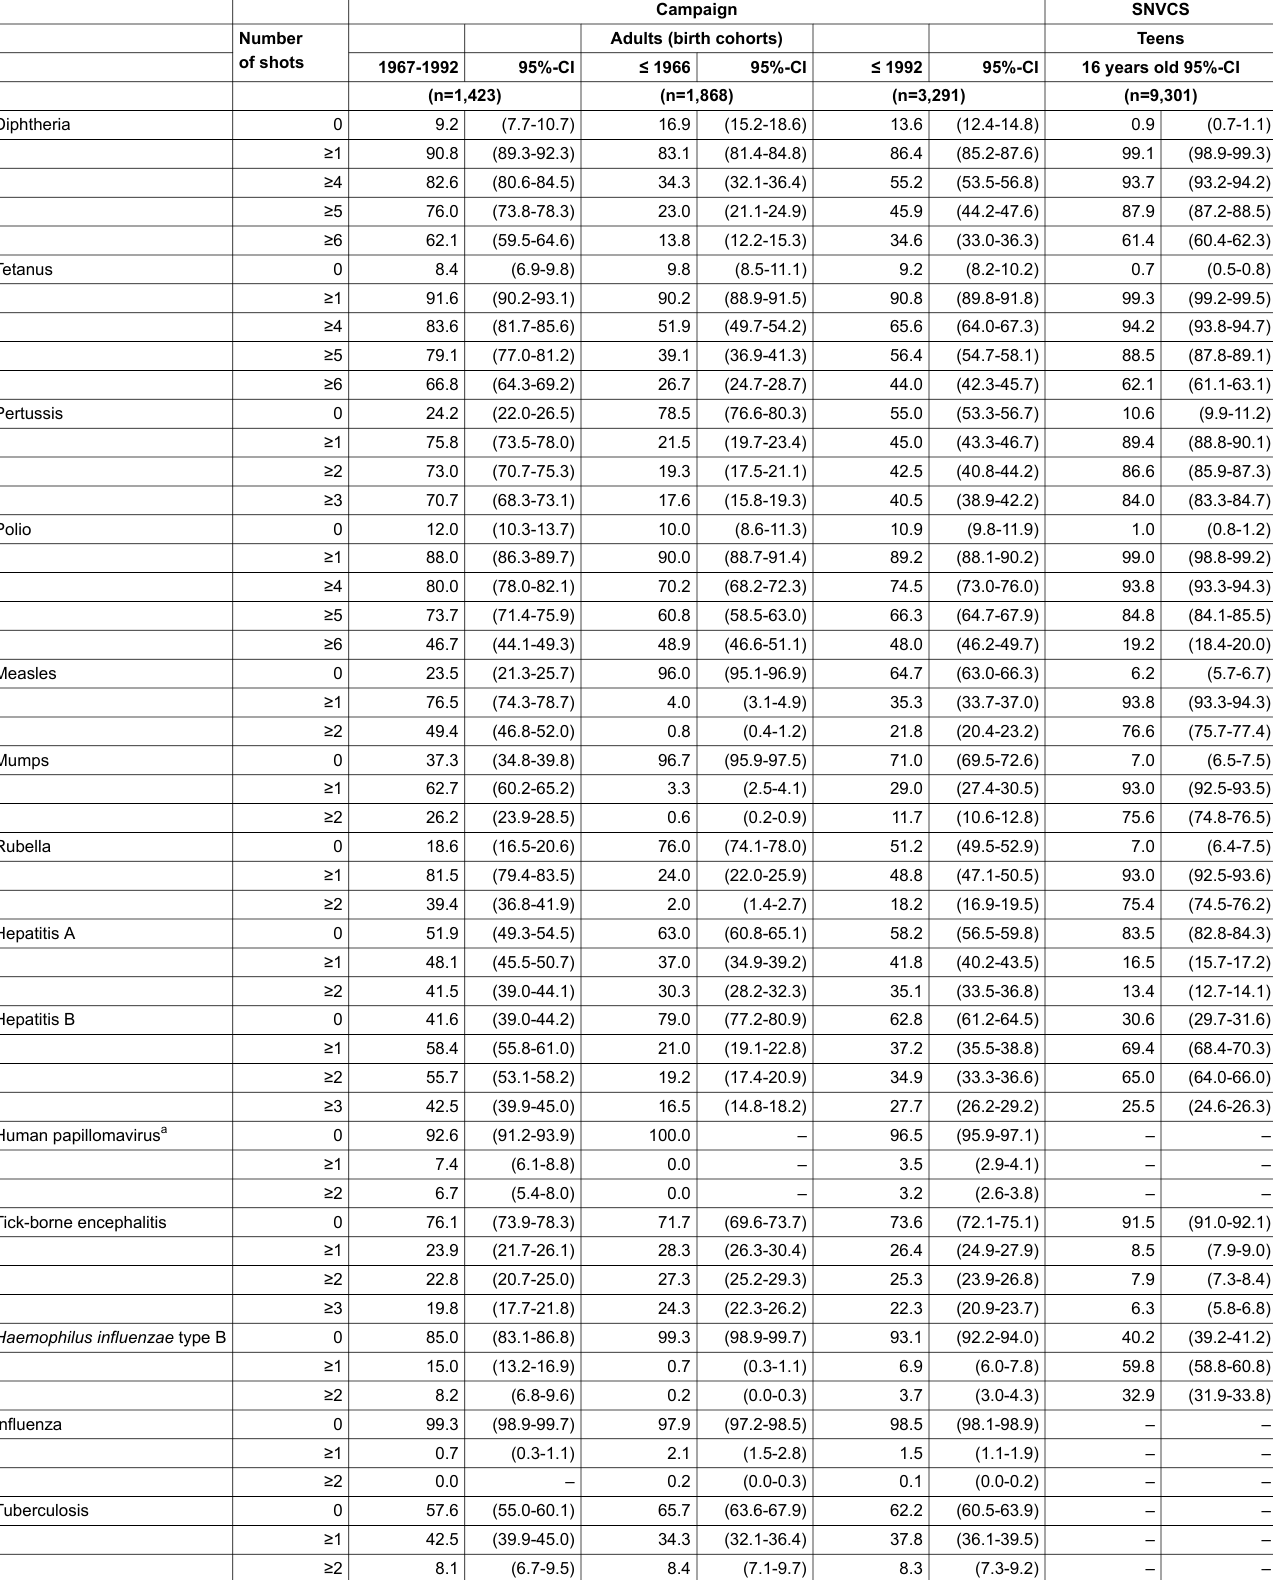
Table 2: Vaccination coverage and 95-% confidence intervals (in %) of adults in birth cohort 1967–1992 and those in birth cohort ≤ 1966 from campaign. The last column is the coverage rate of teens 16 years of age from the Swiss National Vaccination Coverage Survey 2005–2007. Coverage is not